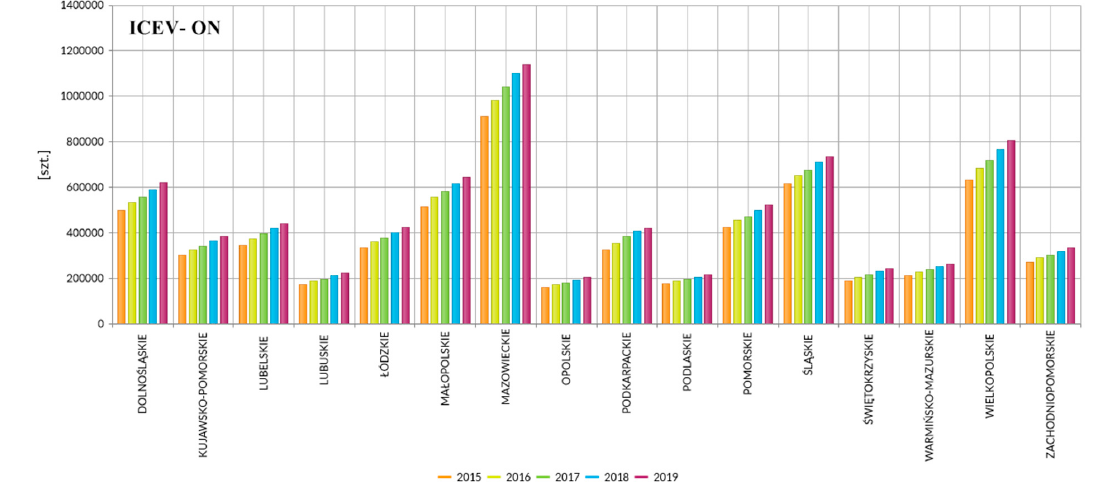
Figure 3. Number of ICEV diesel vehicles.